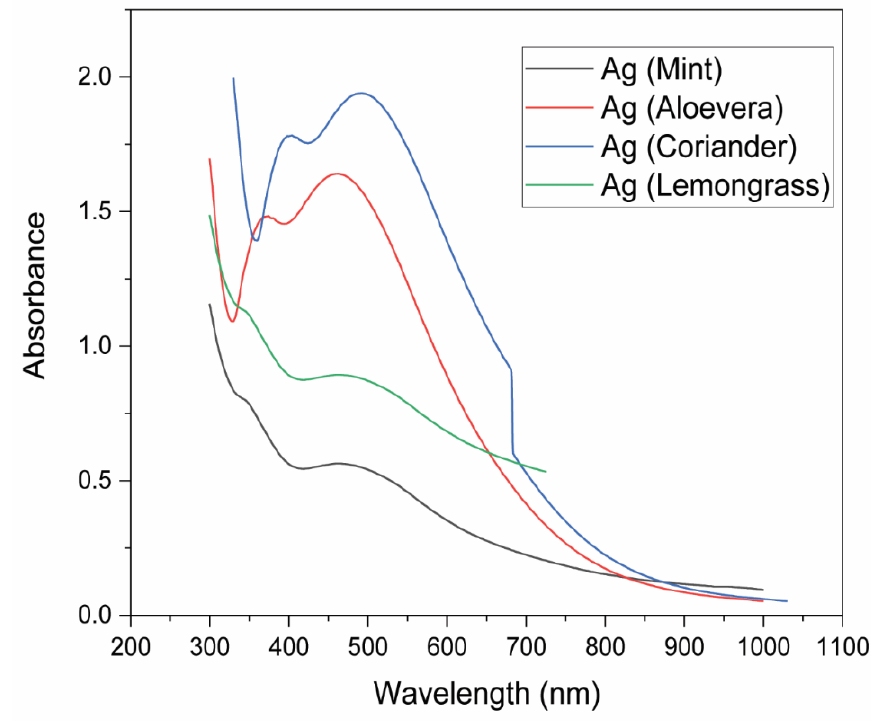
Figure 1. UV – visible spectrum of green synthesized NPs. Figure 1. UV–visible spectrum of green synthesized